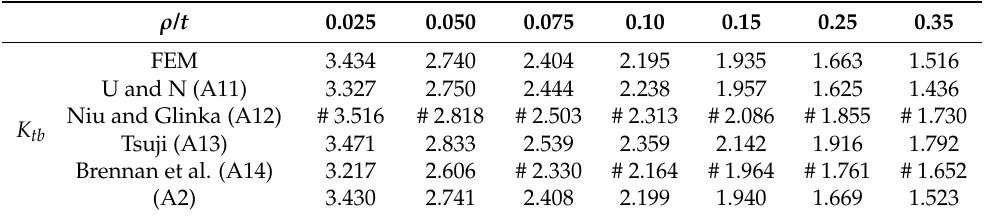
Table 10. Accuracy of Equations (A2) and (A11)–(A14) for the T-joint subjected to bending,